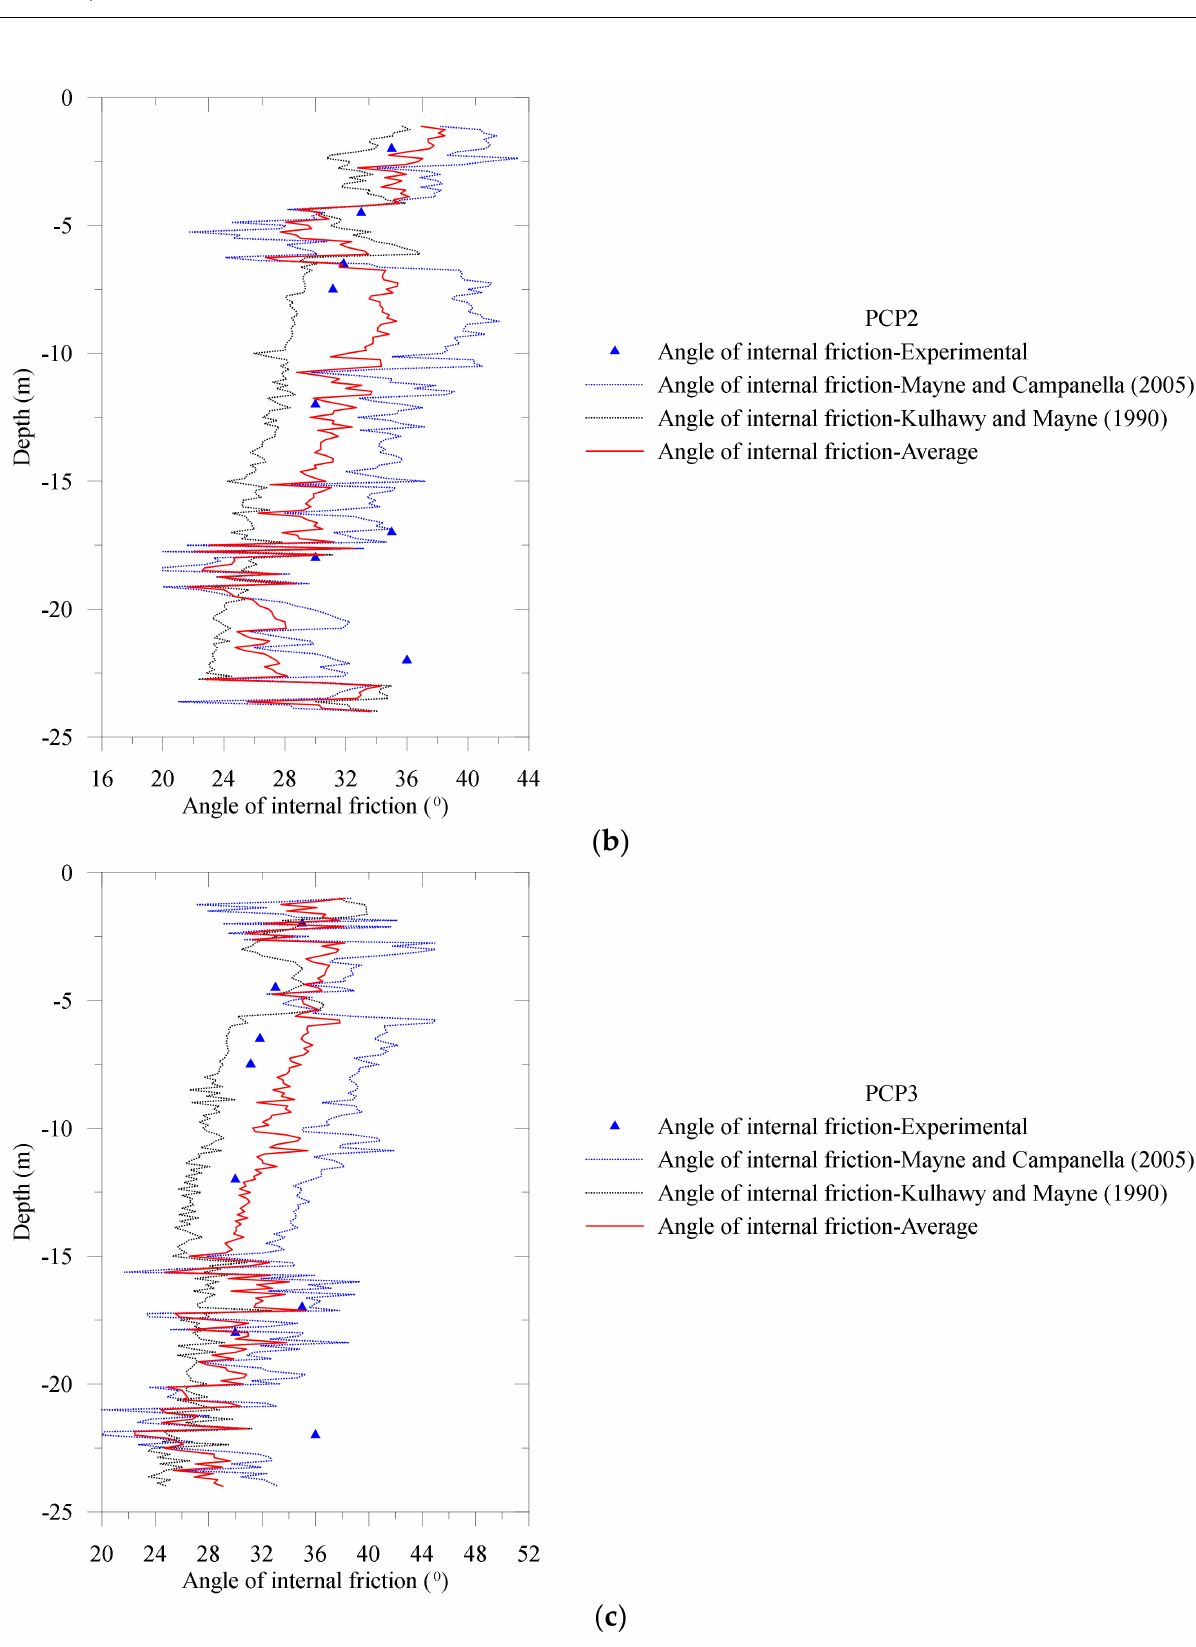
Figure 8. Angle of internal friction of the Nerang Broadbeach Roadway embankment foundation. ( a ) PCP1, ( b ) PCP2 and ( c )